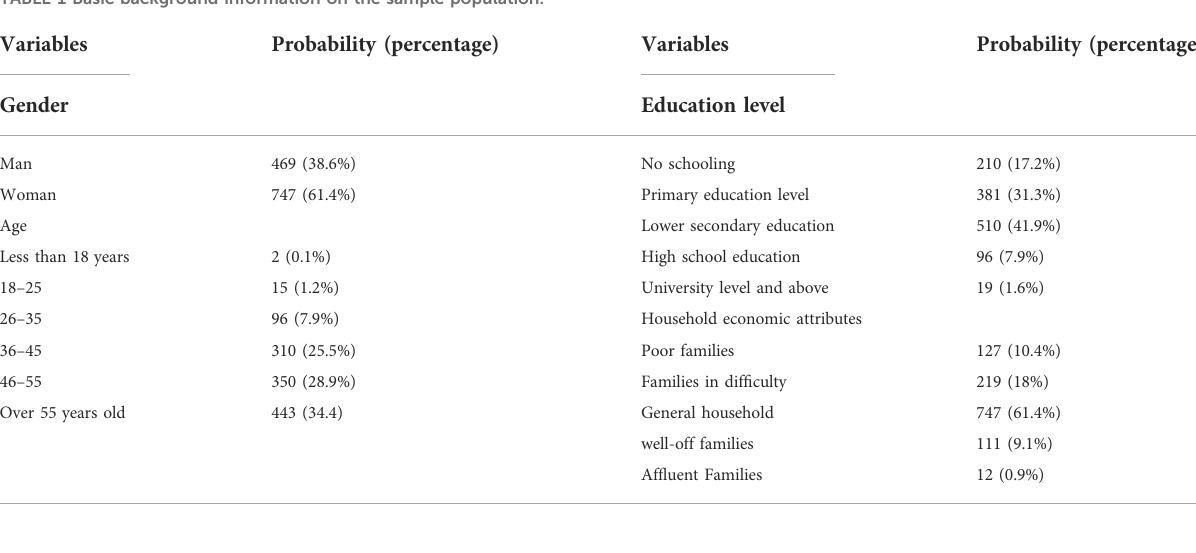
TABLE 1 Basic background information on the sample population.